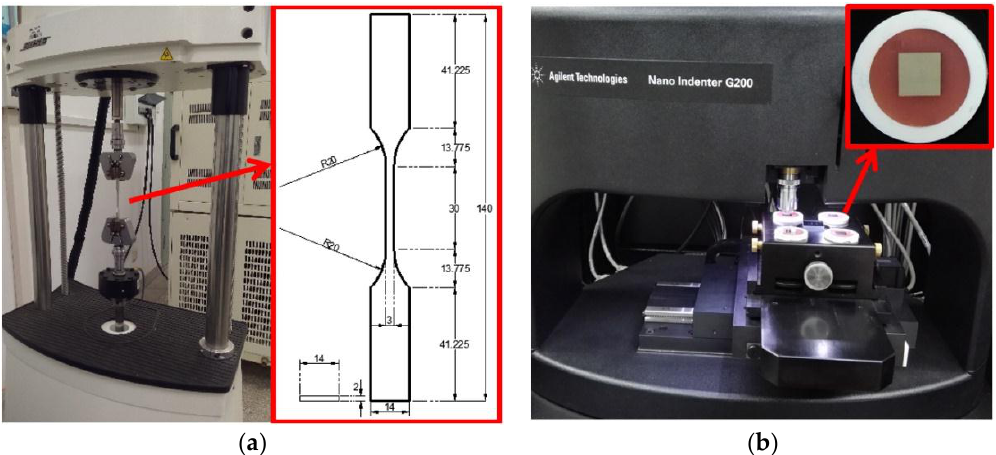
Figure 1. Experimental equipment and material sample. ( a ) Tensile experiment (unit: mm); ( b ) nanoindentation experiment.